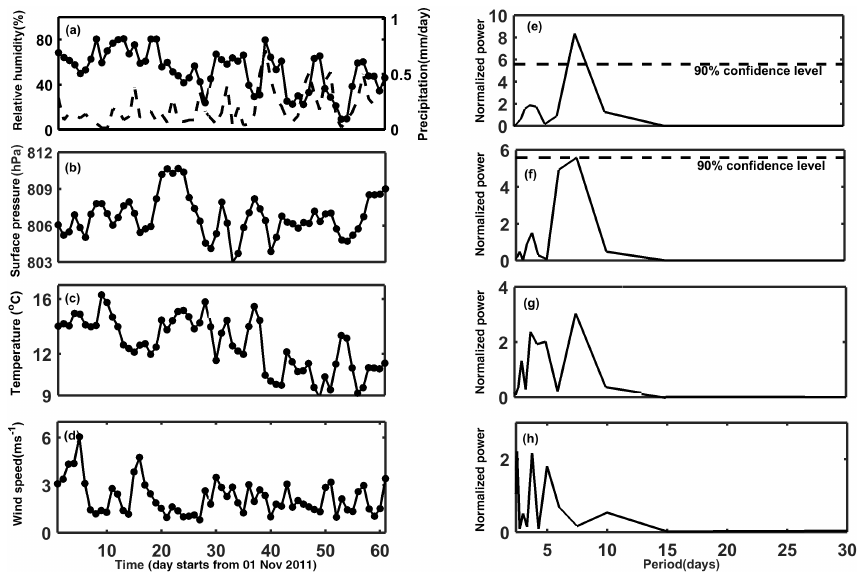
Figure 3. Left column: time series of surface meteorological parameters such as (a) RH, (b) pressure, (c) temperature, and (d) wind speed at ARIES, Nainital, from 1 November to 31 December 2011. The rainfall measured by the TRMM is also overlaid in (a) during the ob- servational period (dashed line). Right column: the corresponding power spectrum estimated from Fourier analysis of (e) RH, (f) pressure, (g) temperature, and (h) wind speed